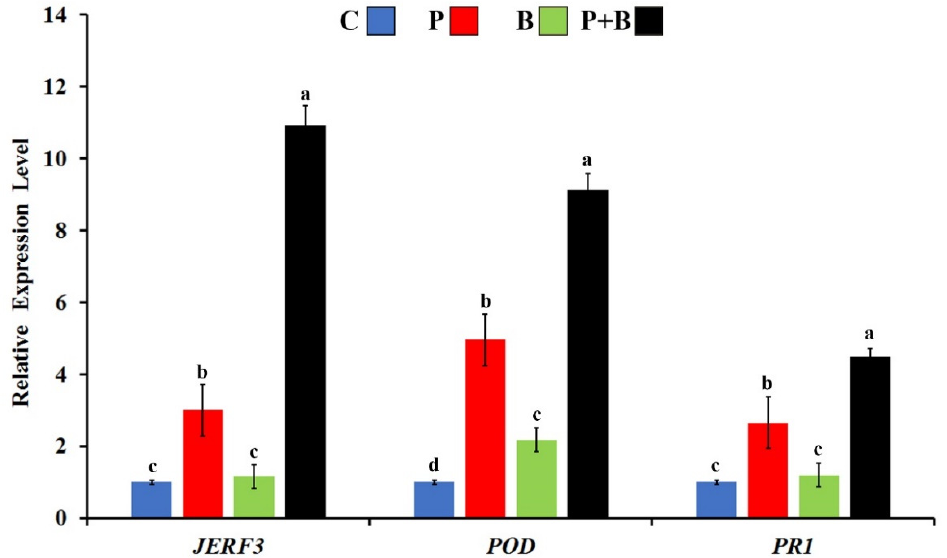
Figure 4. Expression profile of jasmonate and ethylene-responsive factor 3 ( JERF3 ), peroxidase ( POD ), and pathogenesis-related protein 1 gene ( PR1 ) in tomato roots infected with Rhizoctonia solani and/or treated with Bacillus subtilis SR22 at 7 dpi. C: non treated and uninfected; P: non-treated and infected; B: uninfected and treated with B. subtilis SR22; and P+B: infected with R. solani and treated with B. subtilis SR22. For each gene, columns superscripted with the same letter are not significantly different according to Tukey’s HSD test at p ≤ 0.05. For each sample, three biological and three technical replicates were used. Error bars represent standard errors.